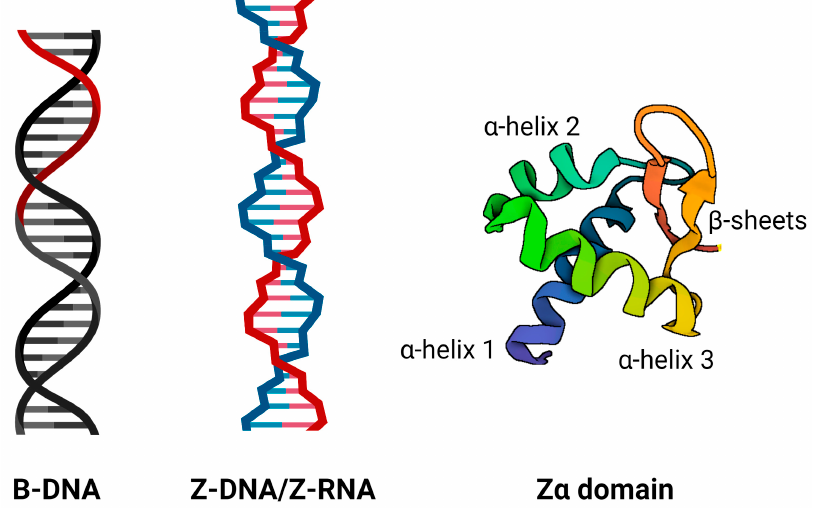
Figure 1. Schematic diagram of classical right-handed B-DNA, left-handed Z-DNA/Z-RNA, and Z α domain consisting of three α -helices and two β -strands. This domain is known to specifically interact with left-handed nucleic acids, mainly through its α -helix 3 and some amino acid residues of beta-strands.